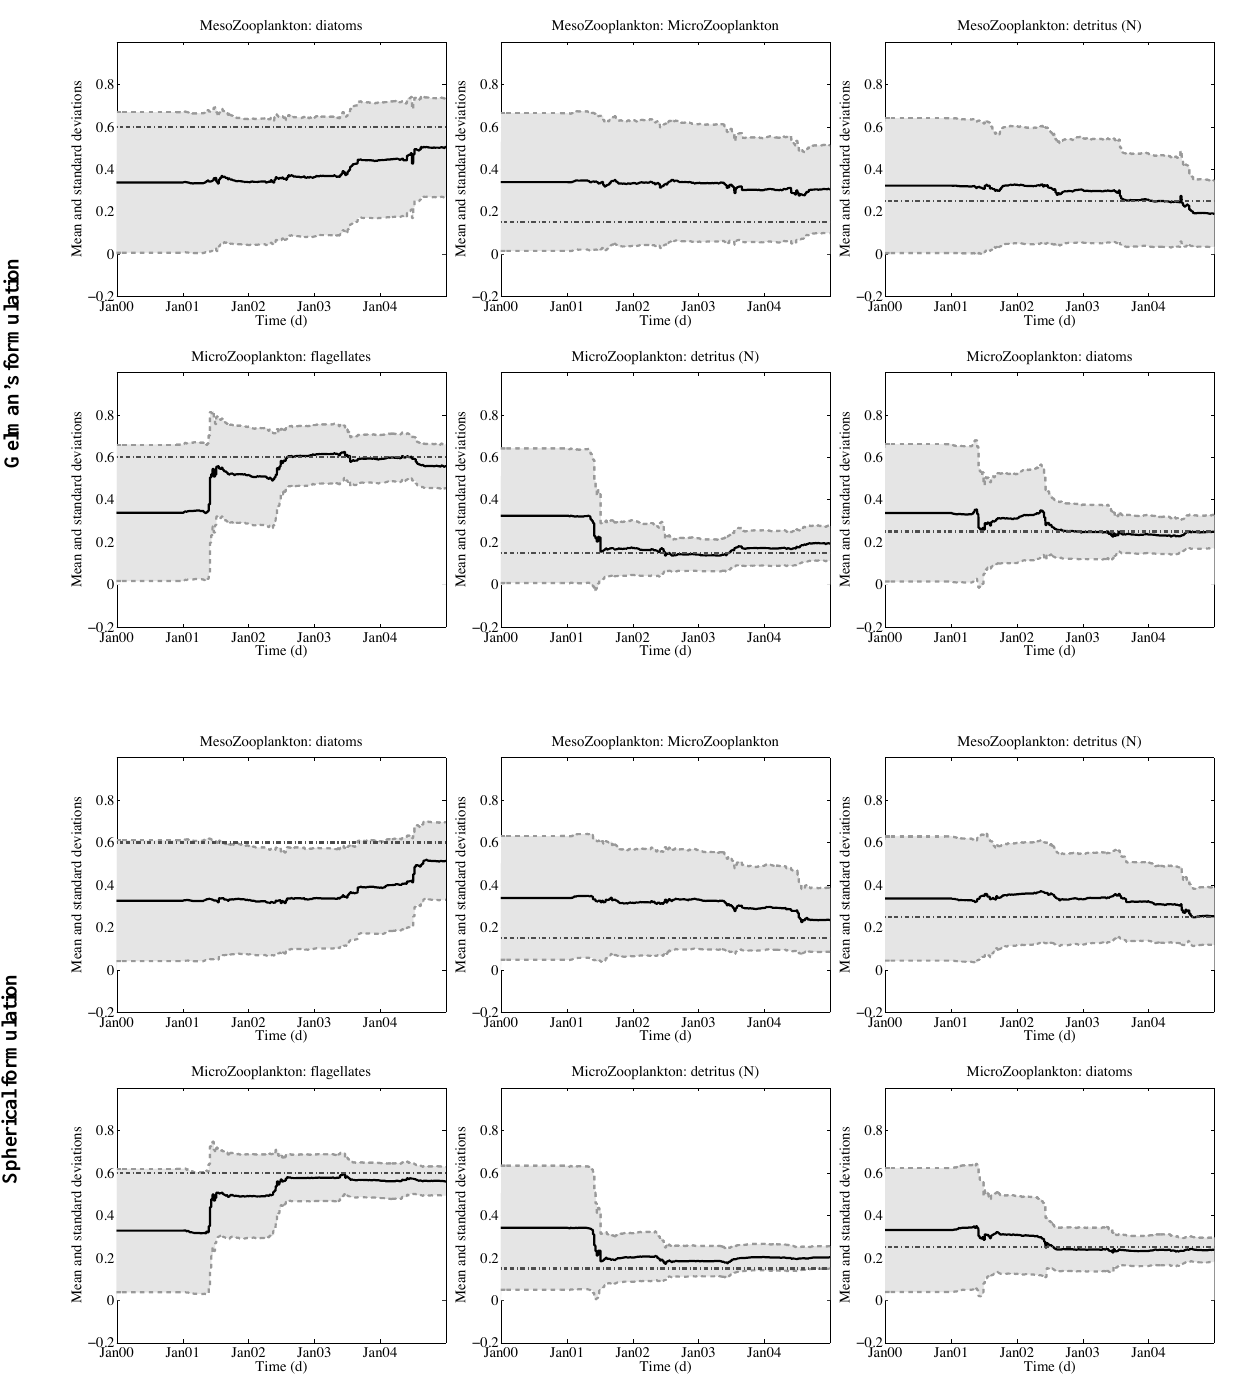
Fig. 4. Evolution with time of the averaged mean (black line) and averaged mean plus/minus the standard deviation (shaded area) of the grazing preferences. The true value is highlighted with a dark dashed-dotted